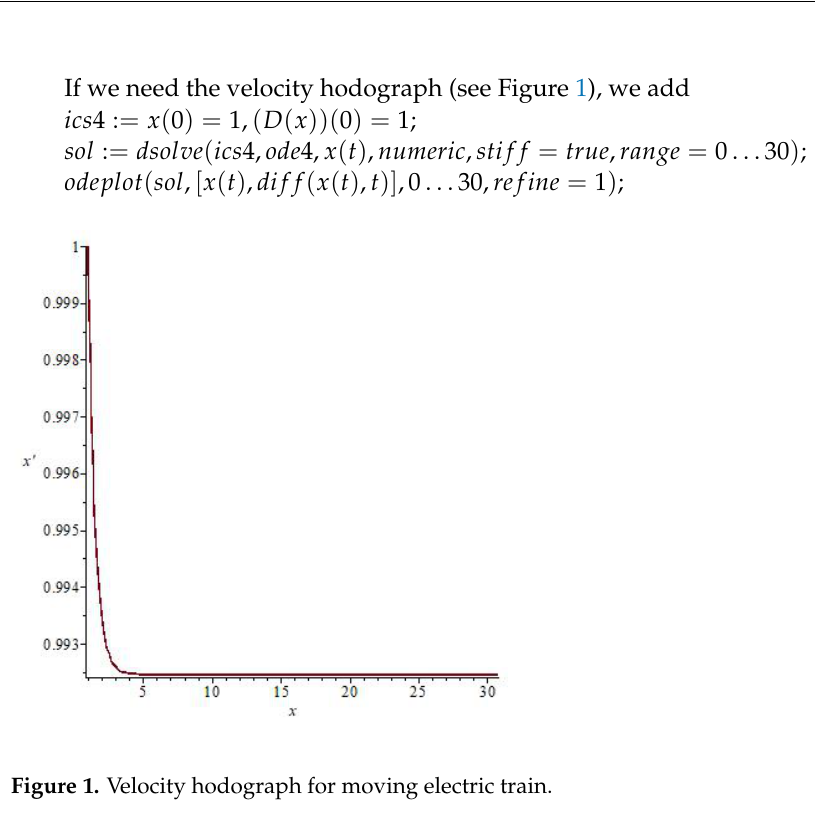
Figure 1. Velocity hodograph for moving electric